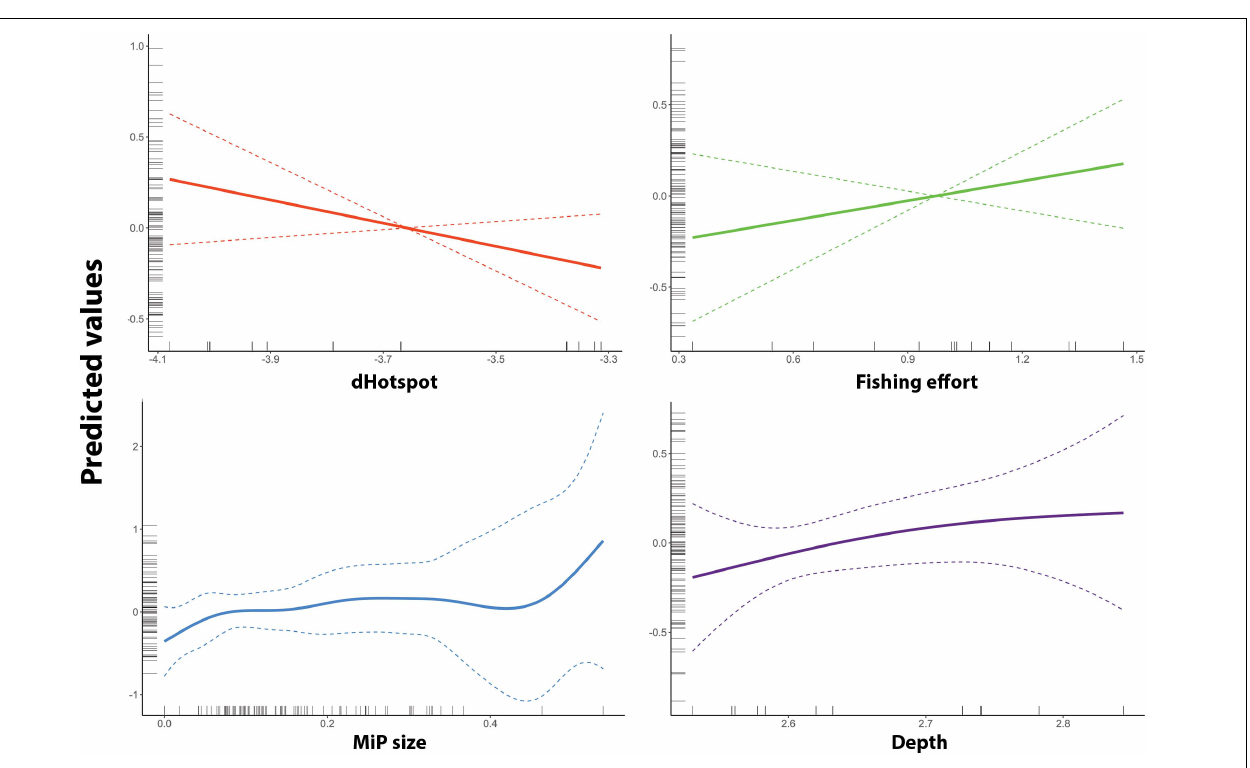
FIGURE 5 | Smooth term prediction for each of the four smooth terms used in the GAM of MiP occurrence. Respectively (on x-axis): Depth (blue), fishing effort (“Fishing Effort” – gold), distance from MaP hotspots (“DistHot” – red), number of MaP items (“MaP” – green). Predicted values (on y-axis) are on log-scale. The dotted line represents 95% confidence